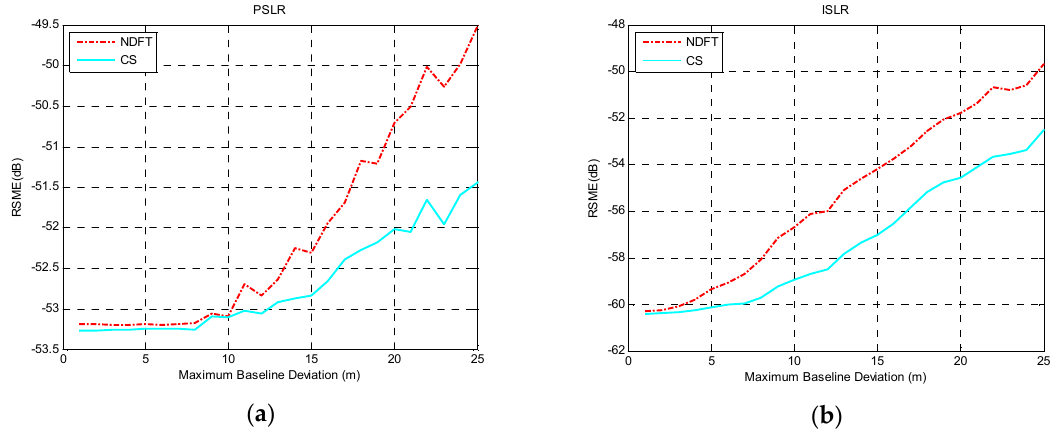
Figure 7. The imaging performance with B span = 500 m: ( a ) PSLR; ( b )